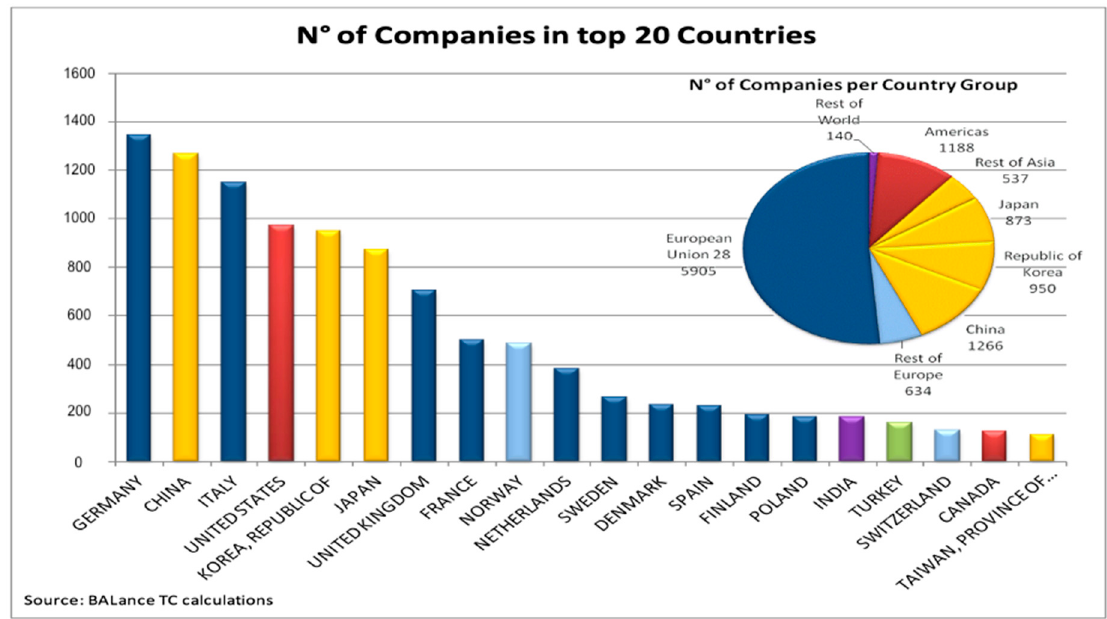
Figure 4. Number of companies in top 20 countries [25].